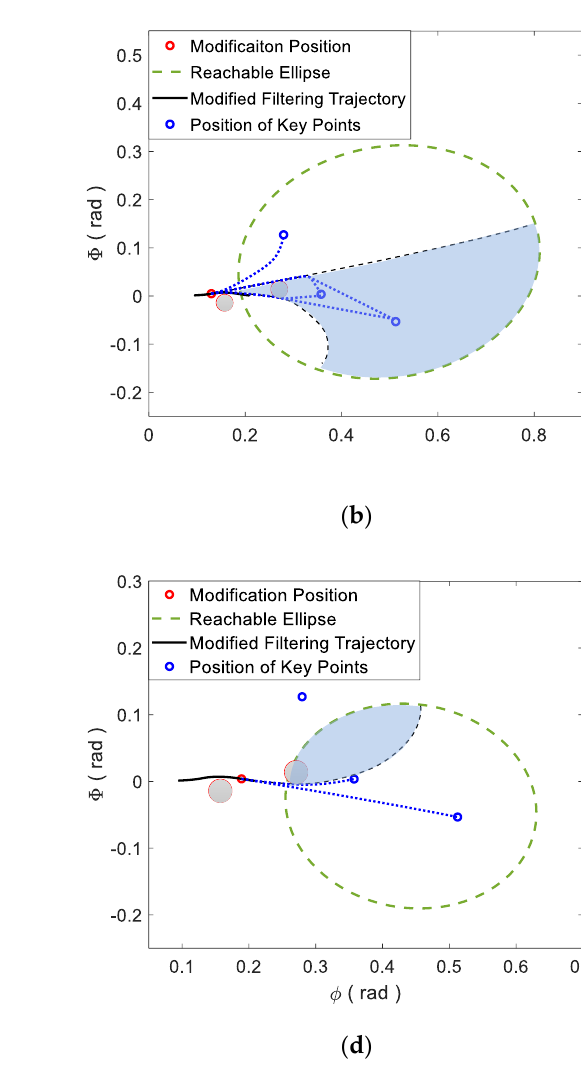
Figure 7. Association model between key points and trajectories:( a – d ) represent the association models at 0s ,40 s, 90 s and 120 s respectively.